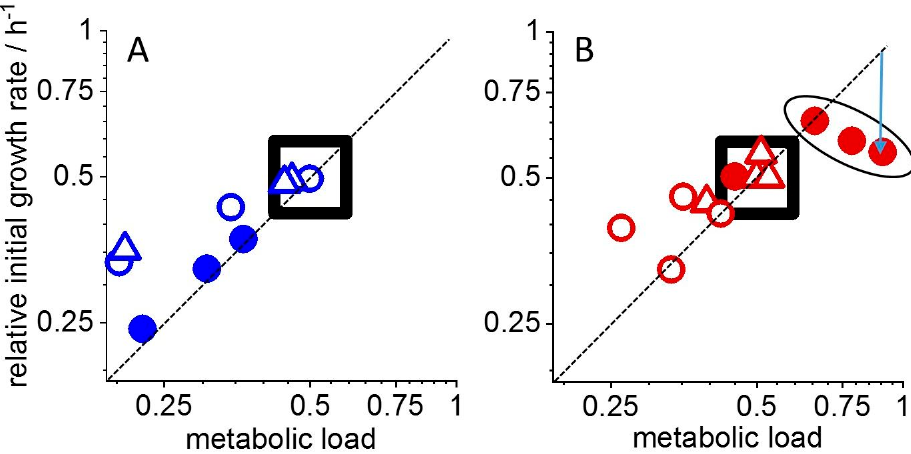
Figure 4. ”Rate plot” of bacterial growth parameters. The initial growth rate r i is plotted against the “metabolic load” for the first (filled circles), second (open circles) and third growth phases (triangles). ( A ) “Rate plot” for concentrations of 0, 100, 150 and 300 µM 153 Eu (data from Figure 2, blue symbols). ( B ) “Rate plot” for concentrations of 0, 130, 320, 630 and 1230 pM 152 Eu (rounded to closest multiple of 10 pM; Figures 3 and S1, red symbols) in the presence of a background concentration of 100 µM 153 Eu. All data were scaled to an initial metabolic load of 0.5 and a maximal growth rate r 0 of unity leading to the reference point [ 0.5;0.5 ] (marked by square boxes) as described [13]. The diagonal (dashed line) corresponds to the change of the relative initial growth rate r i if only the metabolic load was affected by the different Eu concentrations. Deviations from the diagonal indicate an additional increase or decrease of the maximal growth rate r 0 for data points lying above or below the diagonal, respectively, as follows from Equation (3).